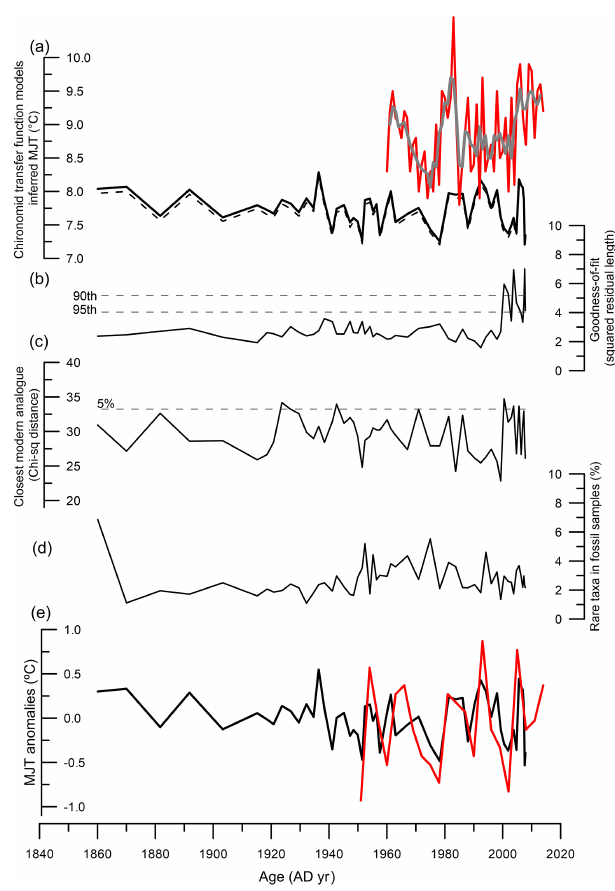
Figure 6. (a) Chironomid-based mean July temperature (MJT) re- construction results from Tiancai Lake based on two transfer func- tion models: the solid black line is the reconstruction based on the weighted-average partial least squares (WA-PLS) bootstrap model with two components and the dashed black line is the reconstruction based on the weighted-average with inverse deshrinking (WAinv) bootstrap model. Red solid line is the instrumental data from Lijiang weather station, corrected applying the lapse rate and solid grey line is the three-sample moving average of the data set. Reconstruction of diagnostic statistics for the 100 lake data set where (b) displays the goodness-of-fit statistics of the fossil samples with MJT. Dashed lines are used to identify samples with “poor fit” (>95th percentile) and “very poor fit” (>90th percentile) with temperature. (c) Near- est modern analogues for the fossil samples in the calibration data set, where the dashed line is used to show fossil samples with “no good” (5%) modern analogues. (d) Percentage of chironomid taxa in fossil samples that are rare in the modern calibration data set (Hill’s N 2 <2). (e) Comparison between the chironomid-based transfer function reconstructed trends (represented by MJT anoma- lies) with the instrumental data from Lijiang weather station (in red solid line, with three-sample moving average). The black solid line represents the reconstruction based on the WA-PLS bootstrapped model with two components using 100-lake calibration